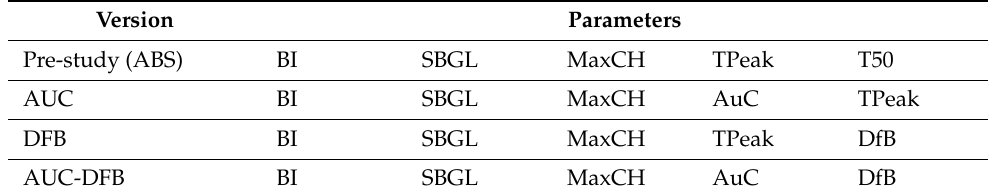
Table 3. Input parameters of the pre-study and the three new